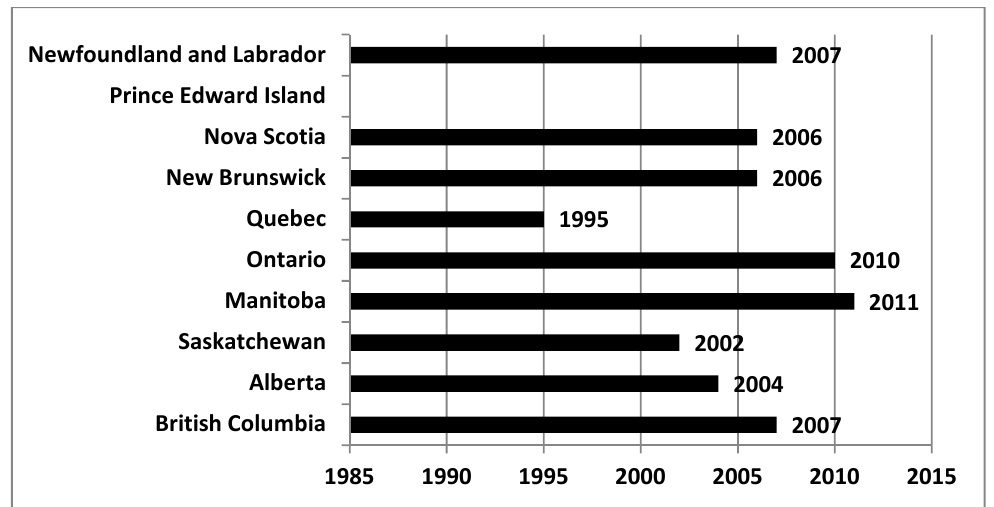
Figure 1: Year of transition to a provincial sector policy